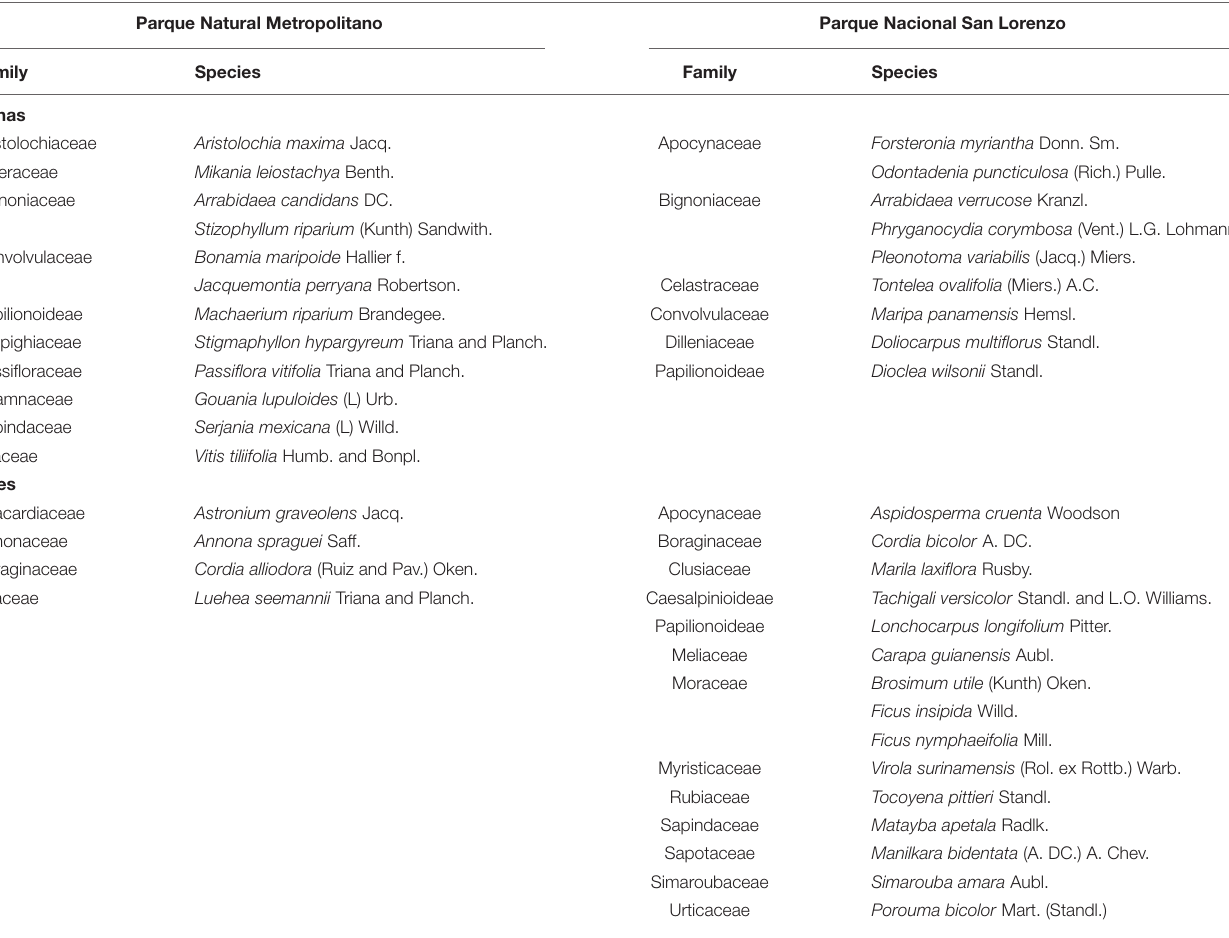
TABLE 1 | List of species of lianas and trees collected at the Parque Natural Metropolitano and Parque Nacional San Lorenzo,